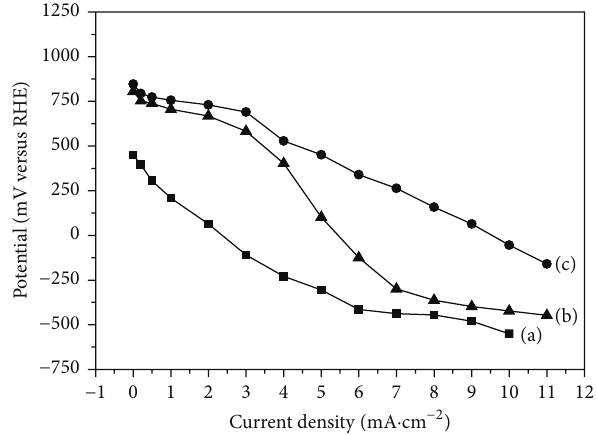
Figure 4: Polarization curves for electrodes from DG + 20% CoPc, with different electrolytes: (a) 10g ⋅ L −1 H 2 SO 3 + 18g ⋅ L −1 NaCl; (b) 10 g ⋅ L −1 H 2 SO 3 + 1M NaOH; (c) 10g ⋅ L −1 H 2 SO 3 + 18g ⋅ L −1 NaCl + 1M NaOH; 𝑡 ∘ = 25 ∘